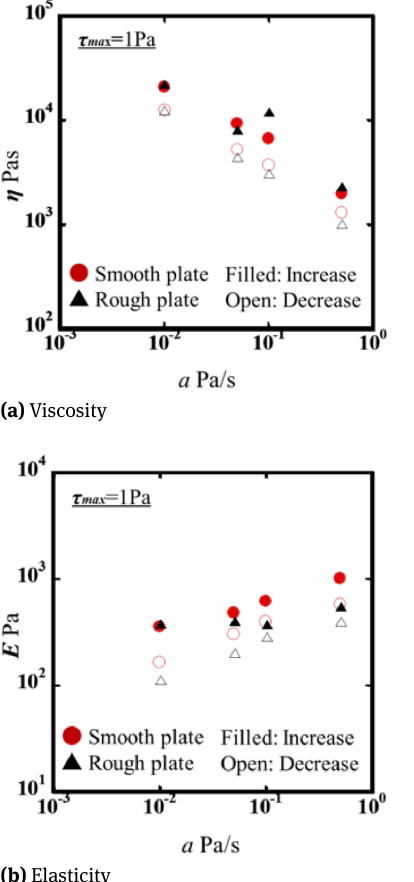
Figure 9: Evaluation of the flow history (time dependence and shear- rate dependence) as a function of the stress-ramp rate for different maximum applied stress. (a) The viscosity ratio and (b) the elasticity ratio (between the coeflcients in the segments of increasing and decreasing